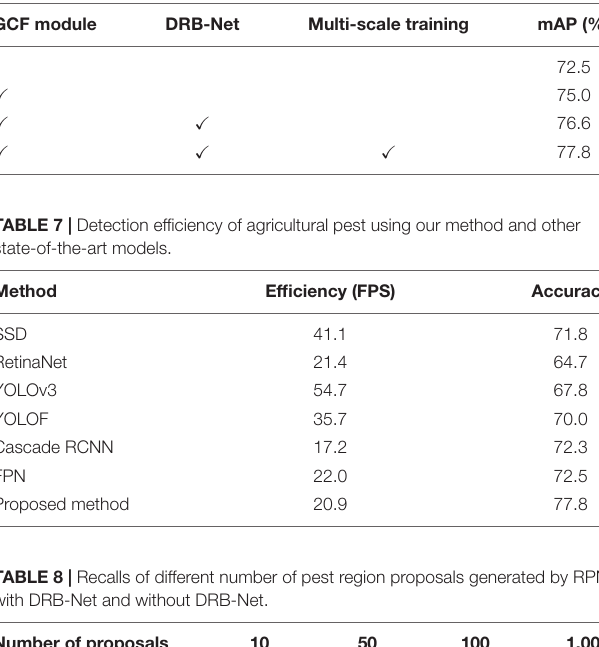
TABLE 5 | Compared results evaluated by strict evaluation criteria. Method